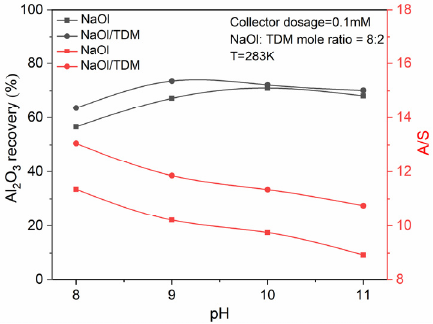
Figure 5. Separation results of mixed minerals under the action of the NaOl (pH = 10, dosage = 0.1 mM) or NaOl/TDM (pH = 9, dosage = 0.1 mM, NaOl:TDM mole ratio = 8:2) collector at 283